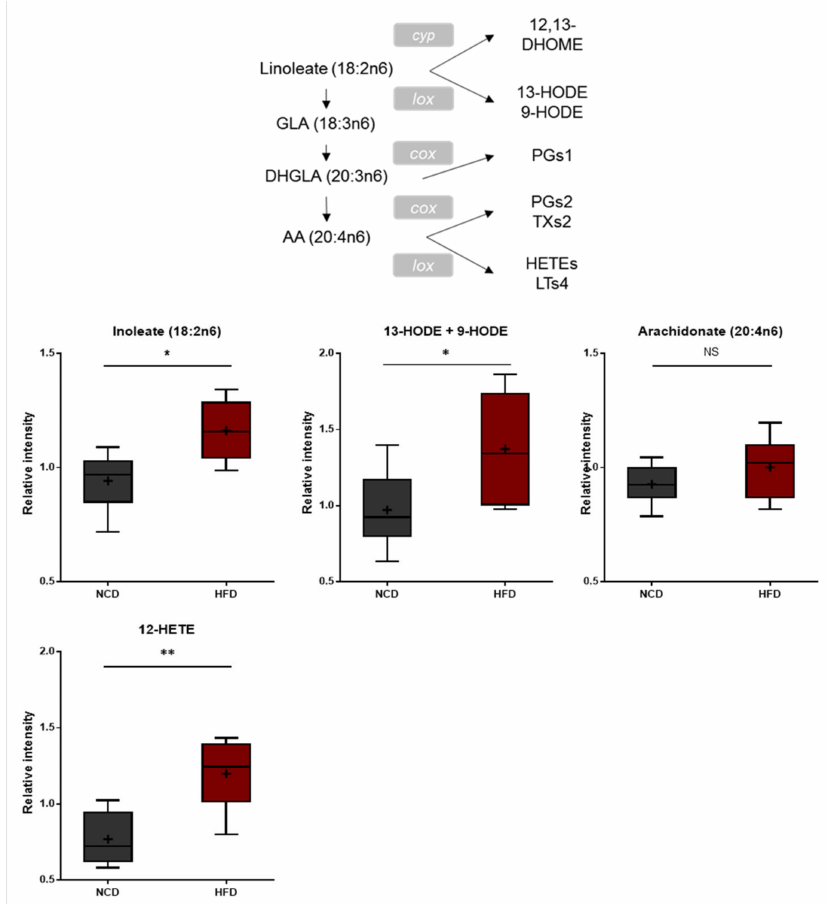
Figure 5. Pathway of statistically significant biochemicals profiled between NCD group and HFD group. In fatty acid, monohydroxy metabolism pathway markers of 13-HODE, + 9-HODE, and 12- HETE were elevated in the HFD group which suggests increased oxidative stress and inflammation. Data were presented as mean ± SD ( n = 6) and two-way ANOVA with Bonferroni’s multiple comparison test. * p < 0.05; ** p <